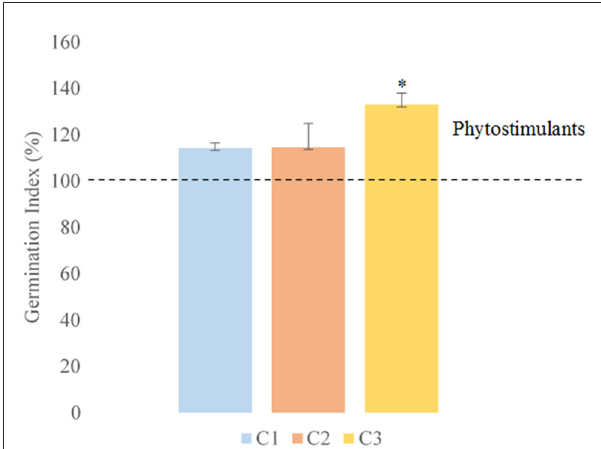
FIGURE3 Germination Index (%) derived from the application of two-member consortia (Consortium 1-C1: A2 + A5; Consortium 2-C2: A2 + A7; and Consortium 3-C3: A5 + A7) with a sodium alginate matrix (0.5%) by biopriming on cucumber seeds. Bars indicate standard error Asterisks show different homogeneous groups with statistically significant differences (Fisher’s LSD test, P < 0.05).